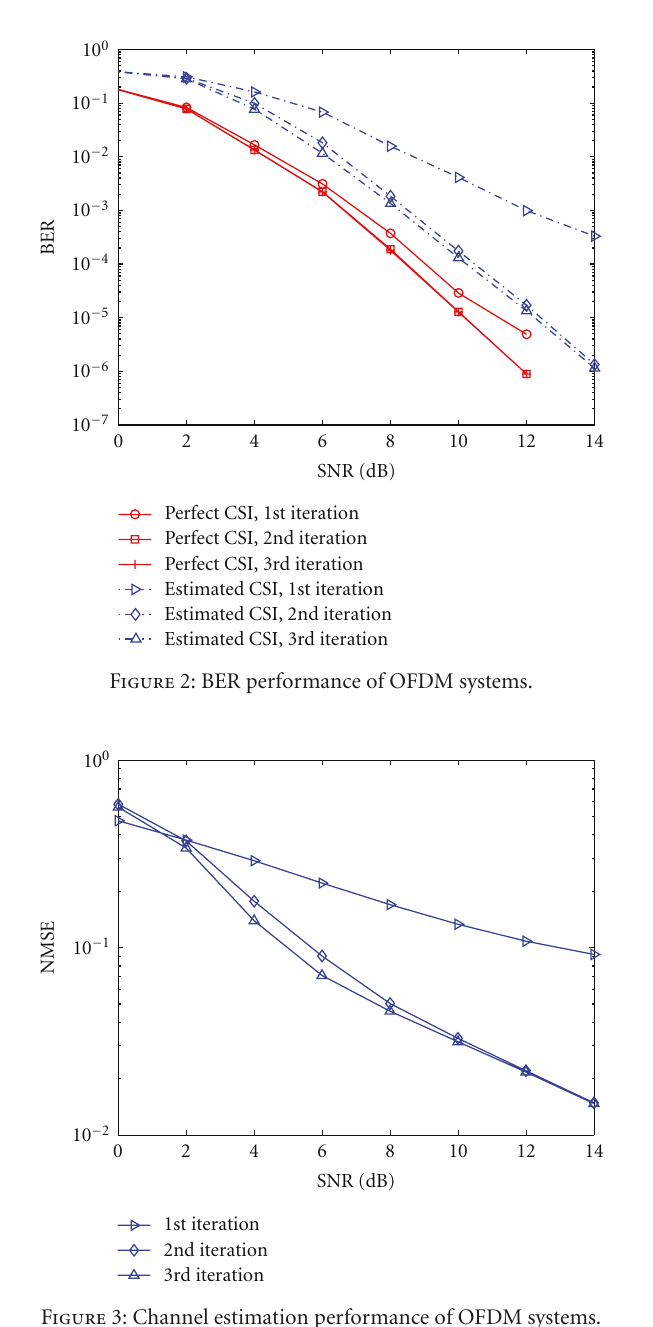
Figure 3: Channel estimation performance of OFDM systems.